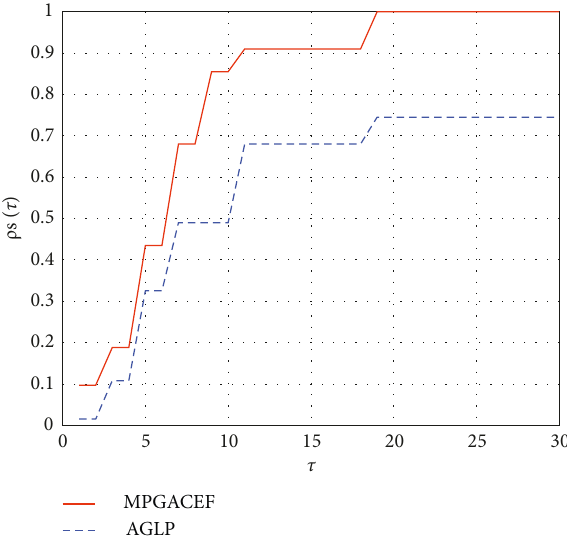
Figure 9: Performance of NIT Time for MPGACEF and AGLP under the condition of